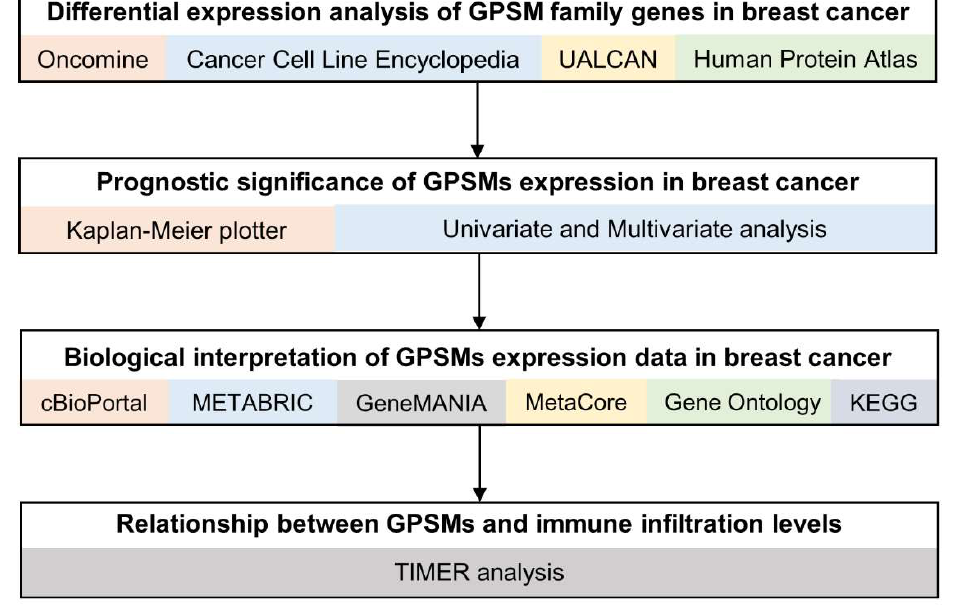
Figure 1. Study flowchart. METABRIC, Molecular Taxonomy of Breast Cancer International Consortium; KEGG, Kyoto Encyclopedia of Genes and Genomes; TIMER, Tumor Immune Estimation Resource.